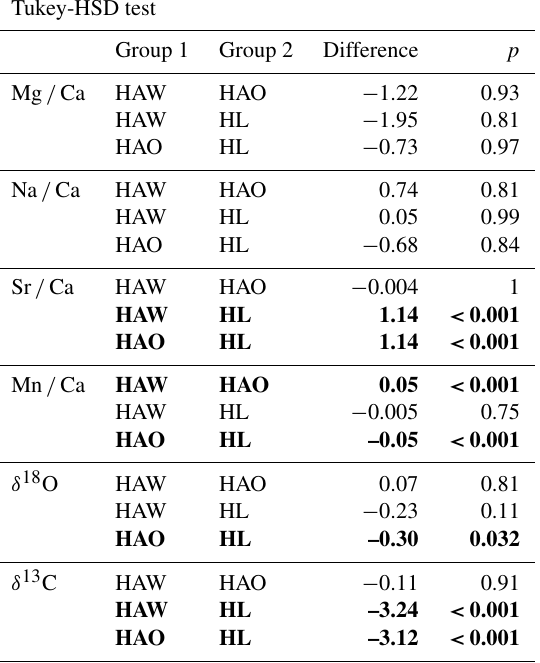
Table 3. Tukey-HSD test results. Bold fields show significant differ- ences between the two groups. HAW represents H. sarcophaga that infested A. excavata with callus formation, HAO 0 H. sarcophaga that infested A. excavata without callus formation, and HL repre- sents H. sarcophaga that infested D. pertusum . p values are Bon- ferroni adjusted.